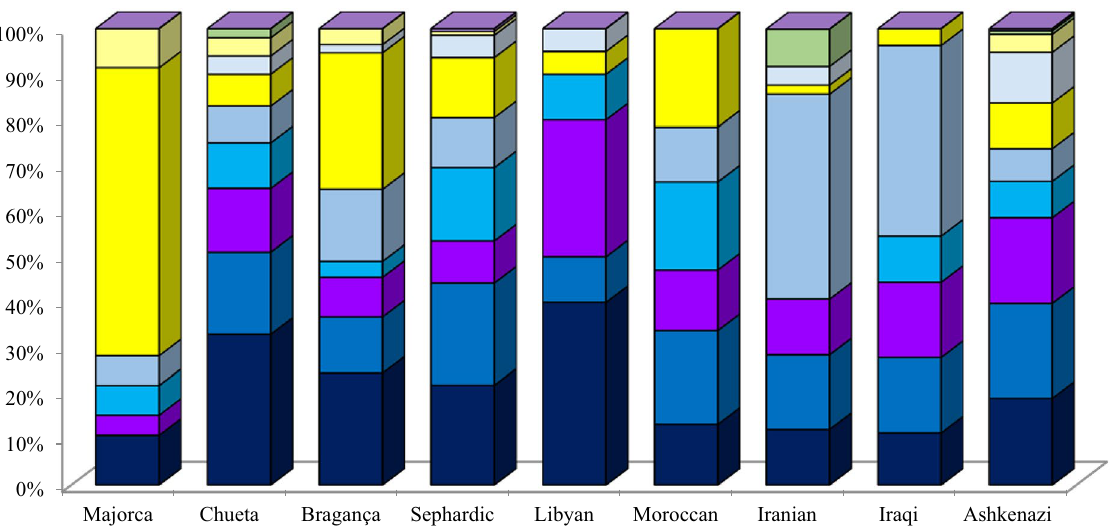
Figure 3. Haplogroup frequencies of mtDNA ( a ) and Y-chromosome ( b ) in Chuetas, Majorcans, and different populations with Jewish origin, based on data from the literature (Supplementary Table 5). Y-chromosome haplogroups are defined with the following SNPs: M172 (J2), 12f2a (J(xJ2)), M35 (E1b1b1), M201 (G), M9(xM173) K(xR1), M173(xM17) R1(xR1a1), M17 (R1a1), M170 (I), M213 (F), M1(xM35)